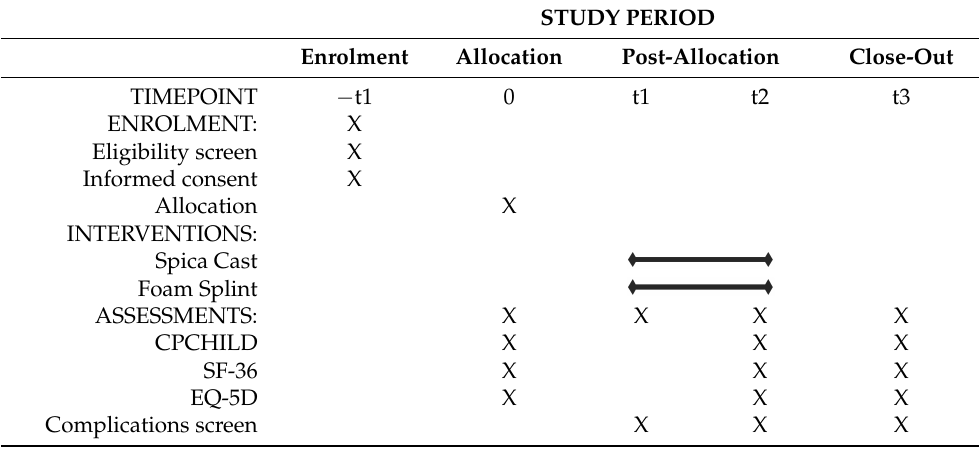
Table 1. Schedule of enrolment, interventions, and